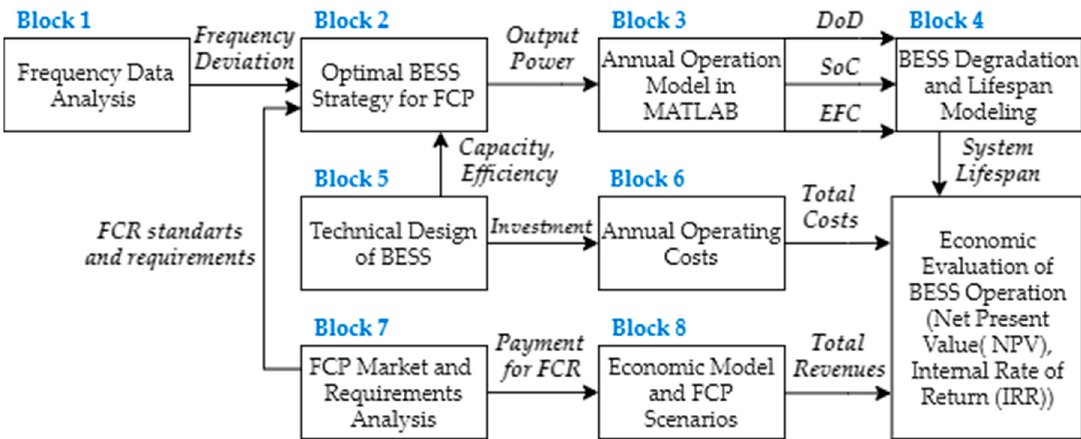
Figure 2. Block diagram representing the proposed methodology and individual parts of the model for evaluating the use of second-life batteries (SLBs) for the battery energy system storage (BESS). FCP: frequency containment process, FCR: frequency containment reserve, DoD: depth of discharge, SoC: state of charge, and EFC: equivalent full cycles.